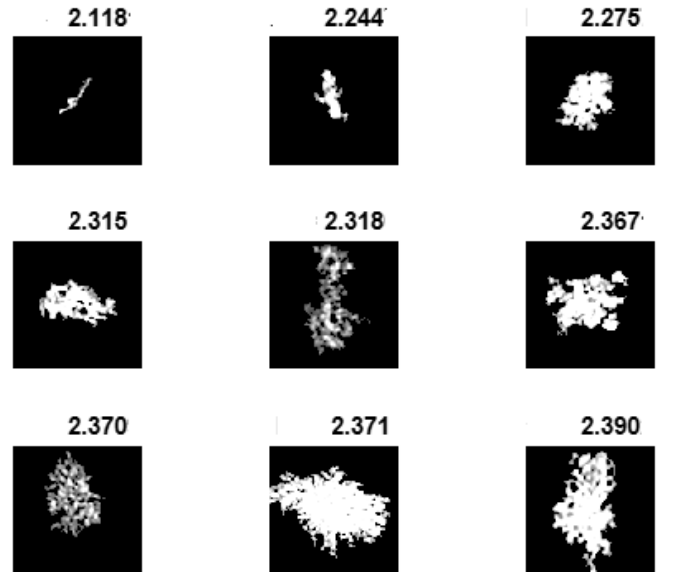
Figure 6. Flocs fractal dimension obtained after 45 min in RAF for the Usumacinta River sediment.